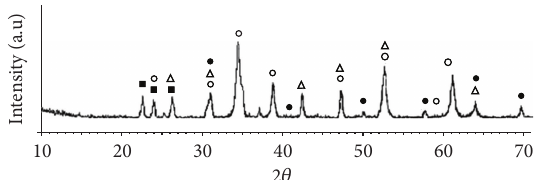
F 4: XRD patterns of the calcined catalyst containing 20wt.